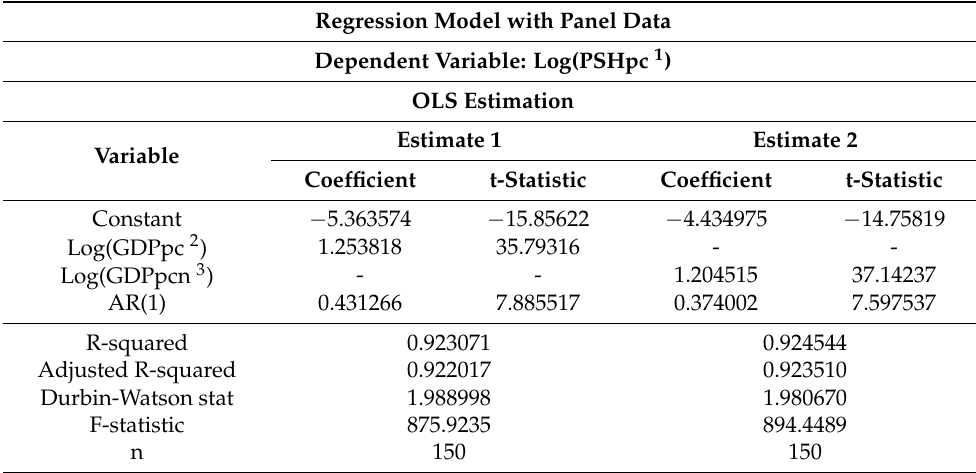
Table 6. Influence of the level of economic development on public expenditure on health (per capita) in the EU-28 Member States